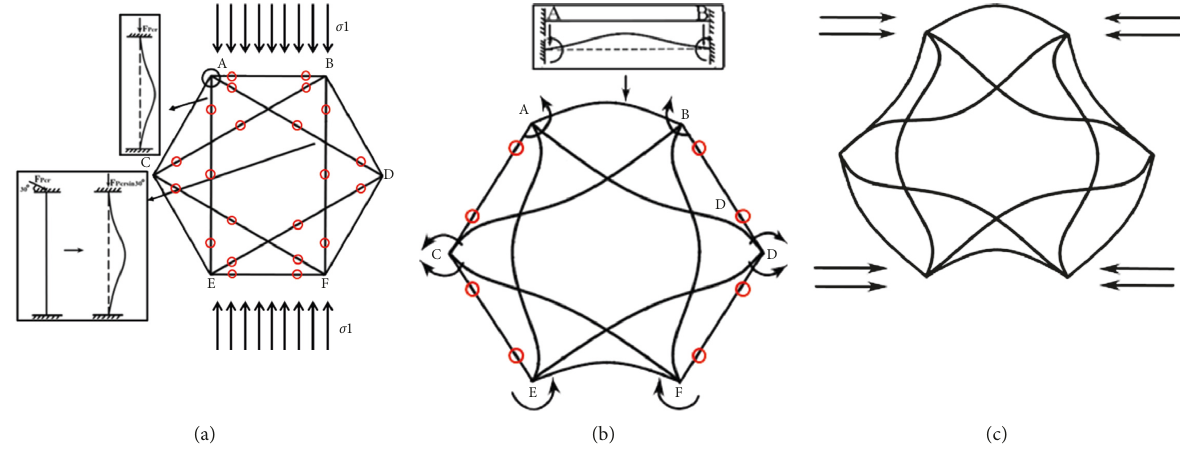
Figure 8: Deformation mechanism of HKH under the low- and mid-velocity